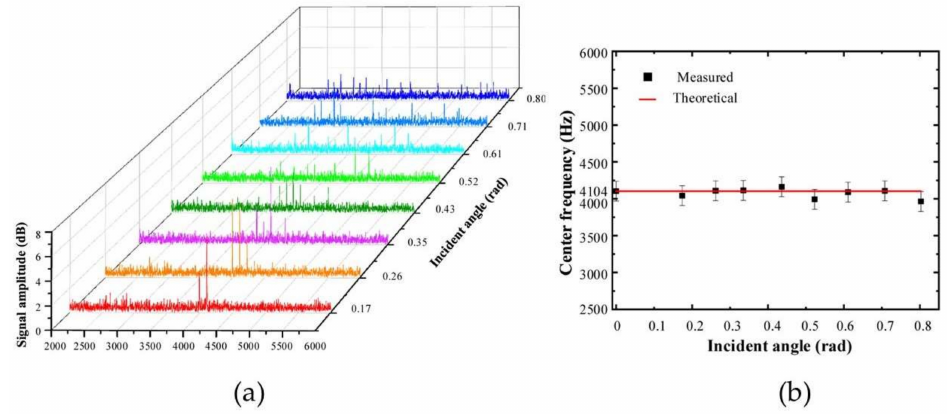
Figure 17. ( a ) Beat spectrum at different incident angles. ( b ) Center frequency at different incident angles. Adapted with permission from ref.